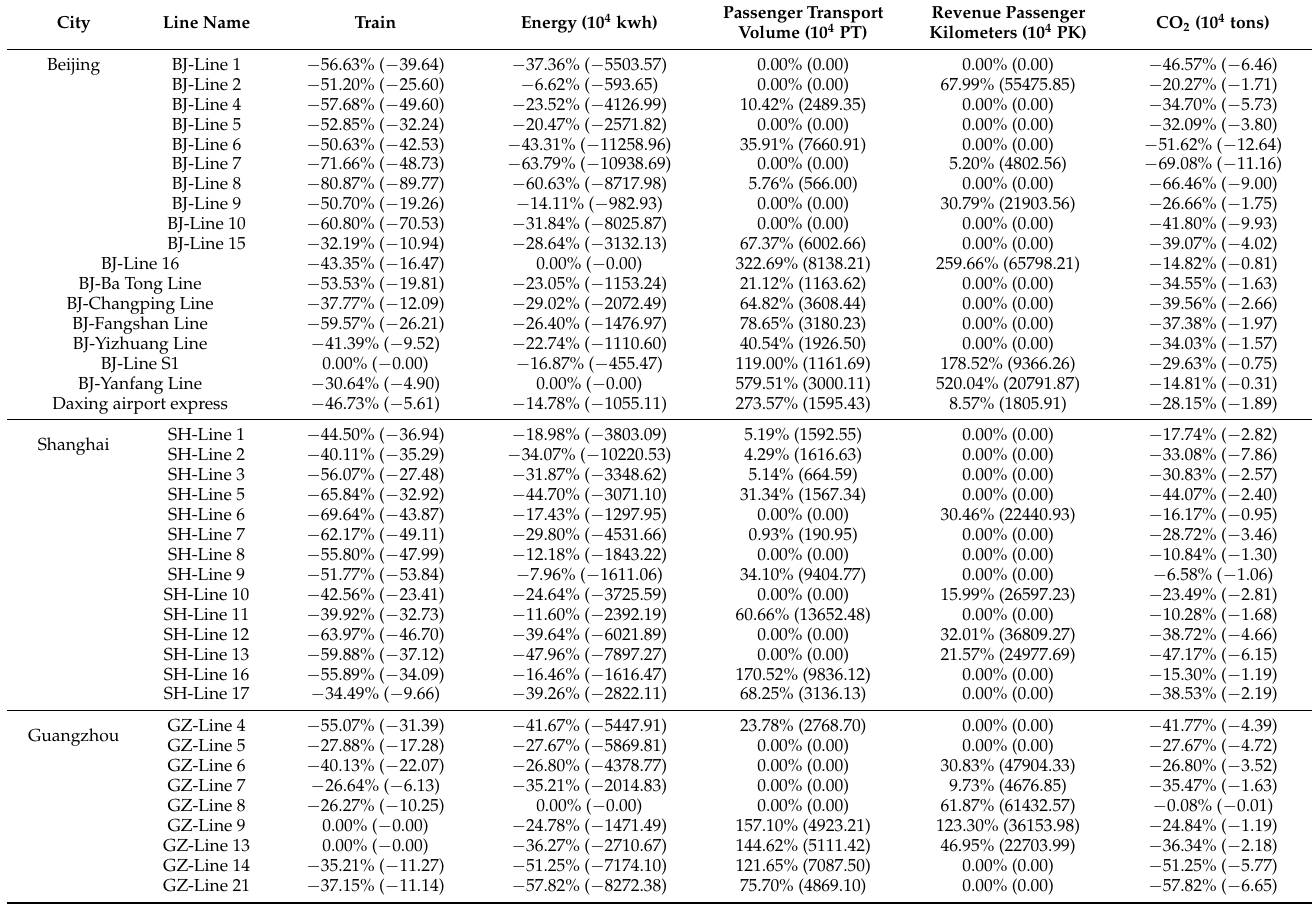
Table 4. The improvement values of the URT systems in case